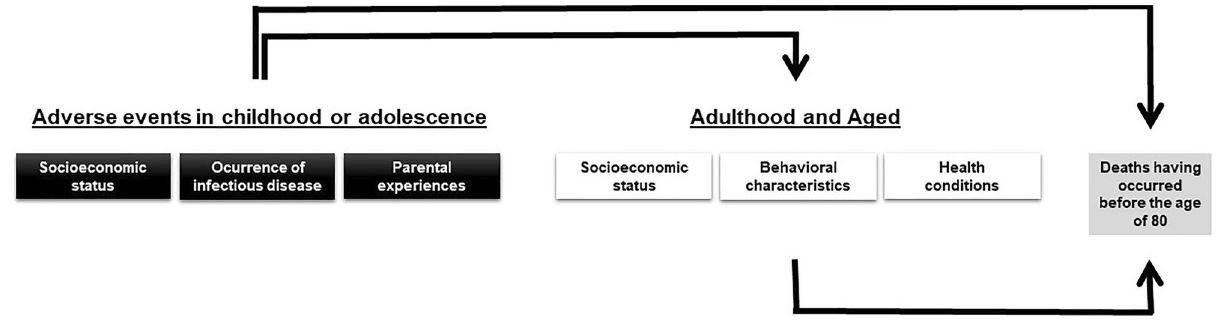
Figure 1. Hierarchical theoretical model of effects of variables of interest on